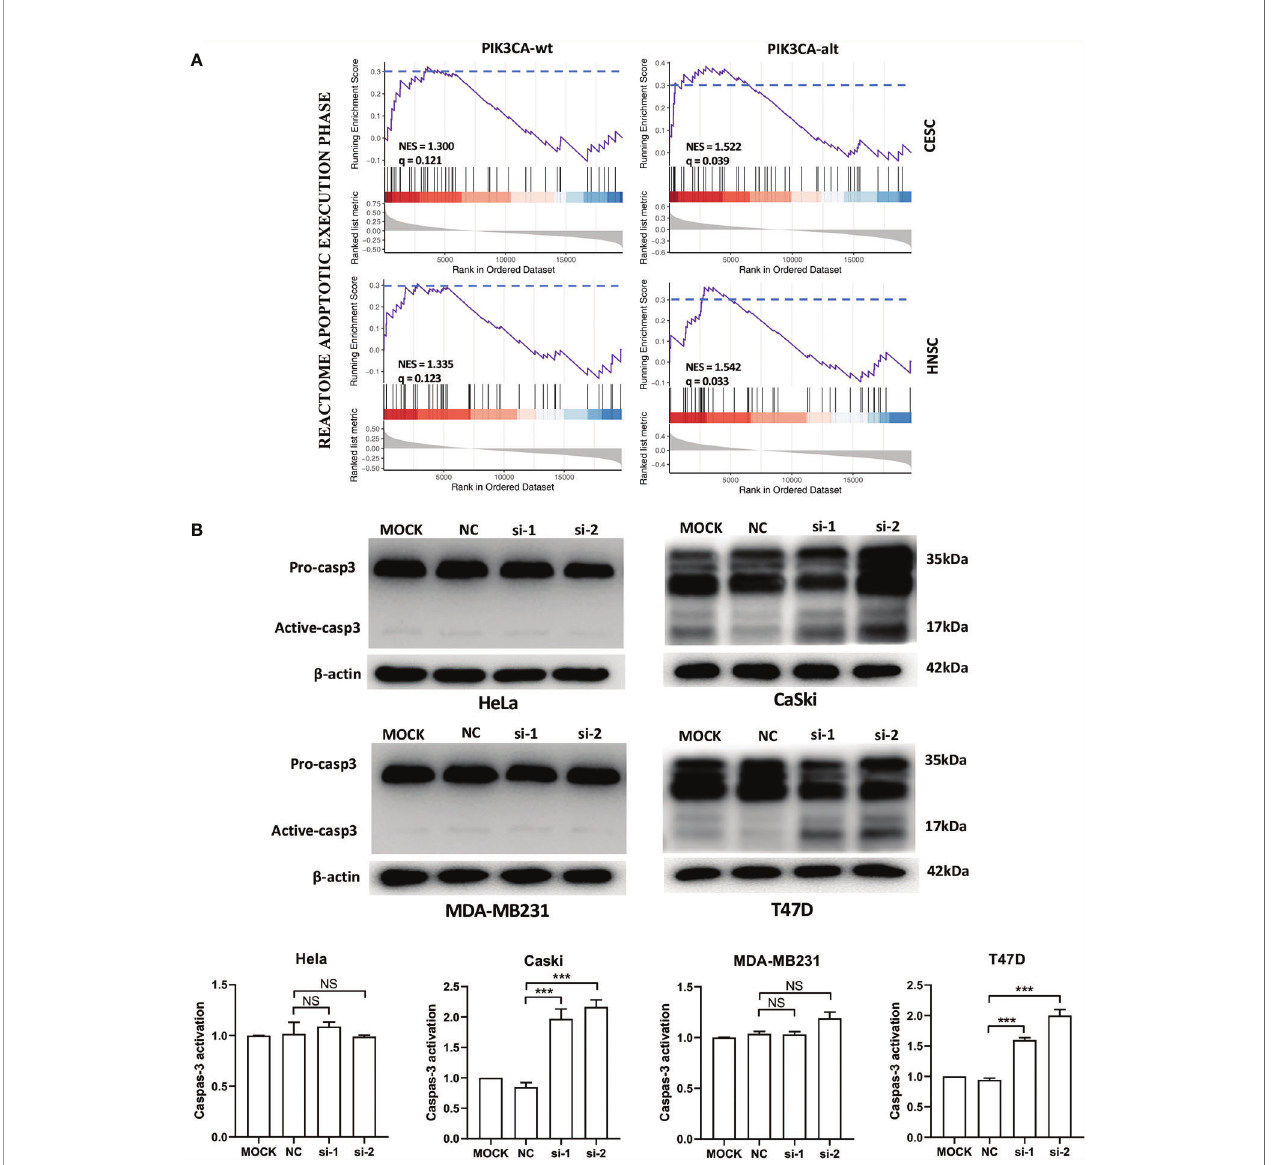
FIGURE 3 | FSCN1 inhibits apoptosis of cancer cells with PIK3CA alterations. (A) FSCN1-correlated genes were enriched in apoptosis-related pathways in patients with PIK3CA alterations. The plots show the results of GSEA of the apoptosis pathway of the Reactome database. NES, normalized enrichment score; q, false discovery rate; PIK3CA-wt, wild-type PIK3CA; PIK3CA-alt, mutated or ampli fi ed PIK3CA. (B) Western blotting analysis of caspase-3 expression in HeLa, CaSki, MDA-MB-231 and T47D cells transduced with FSCN1 siRNA, after 4 Gy IR treatment. Quanti fi ed levels of active-caspase-3 are shown. Data are presented as means±SEM. *** P < 0.001. NS, not signi fi